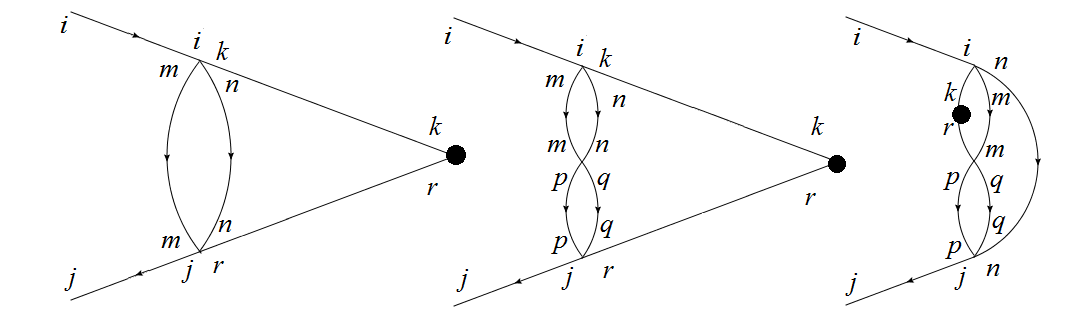
Figure 1 . Feynman diagrams with (cid:21) ijkl parameter. The (cid:12)rst diagram on left is a two loop diagram. The second and third on the right are three loop diagrams. The colour indices are indicated at each vertex. The blobs denote a composite operator ( T or J )